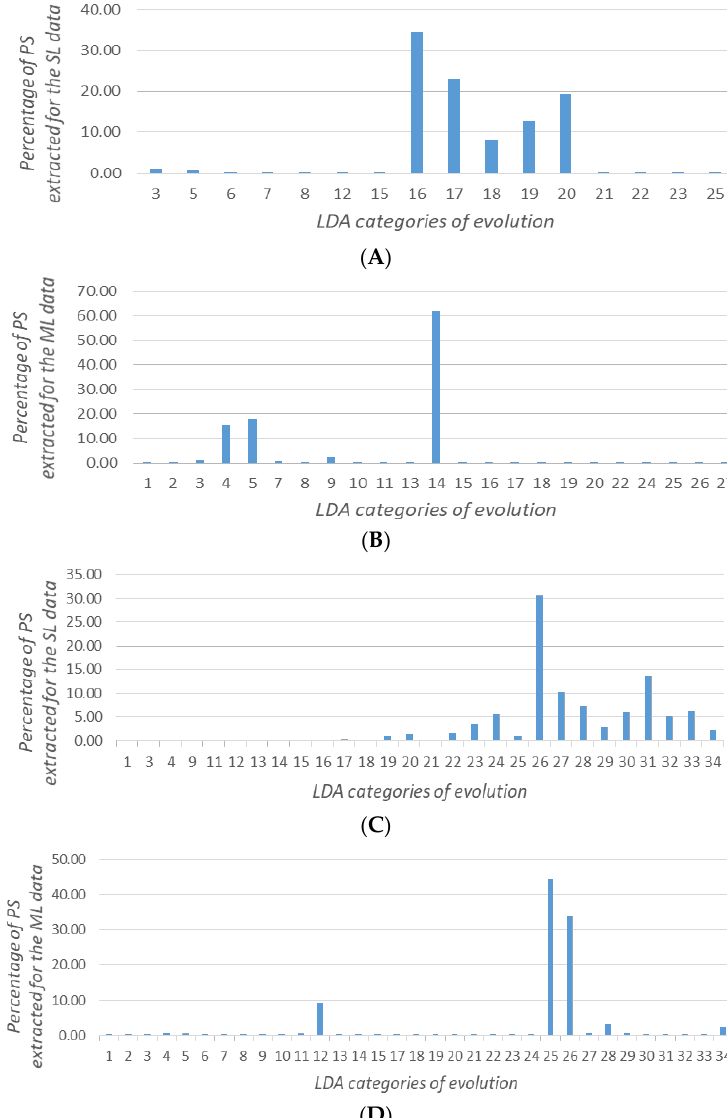
Figure 16. Persistent Scatterer classification based on the LDA categories of evolution. For the ERS dataset: Single-Look approach ( A ), Multi-look approach ( B ) and for the Sentinel-1 dataset: Single-Look approach ( C ), Multi-look approach ( D ).